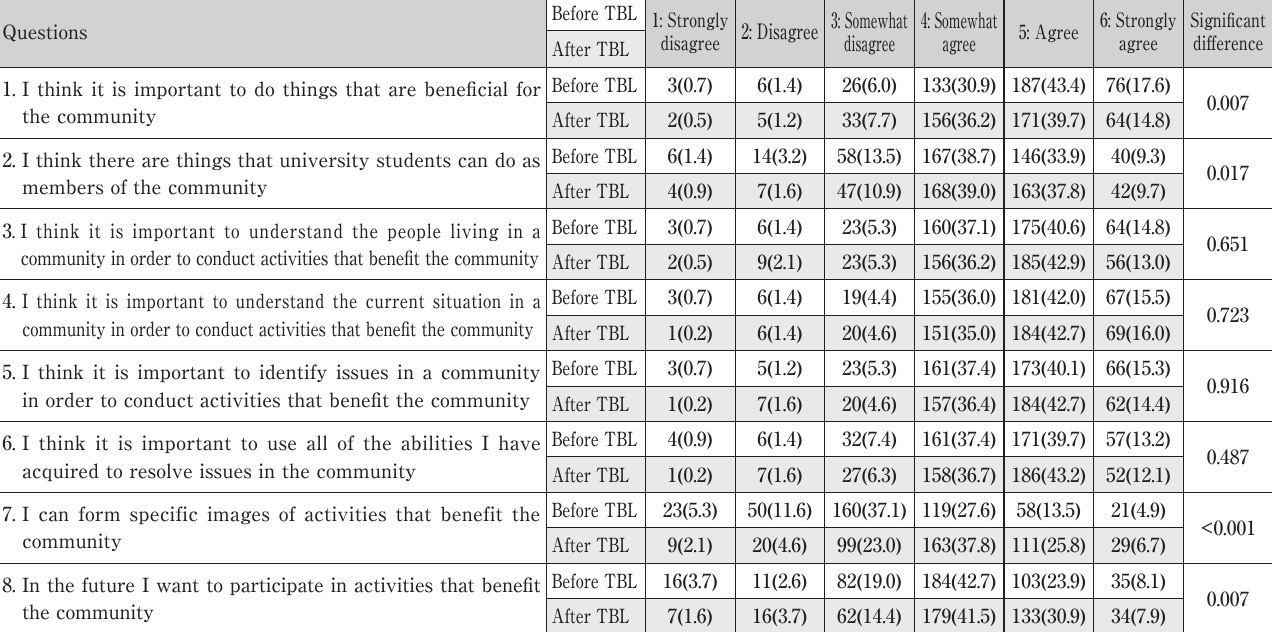
Table 1. Changes in students' attitudes to community service before and after